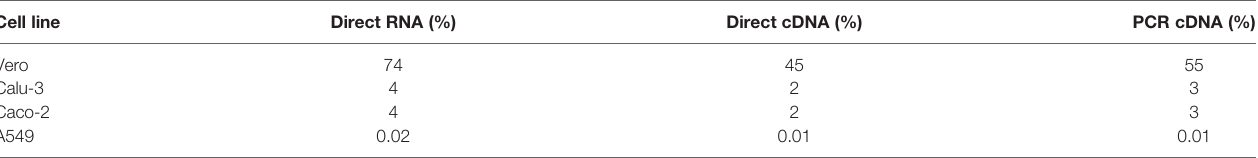
TABLE 1 | Proportions of average viral reads in 24 hpi datasets in Vero, Calu-3, Caco-2 and A549 cell lines. Cell